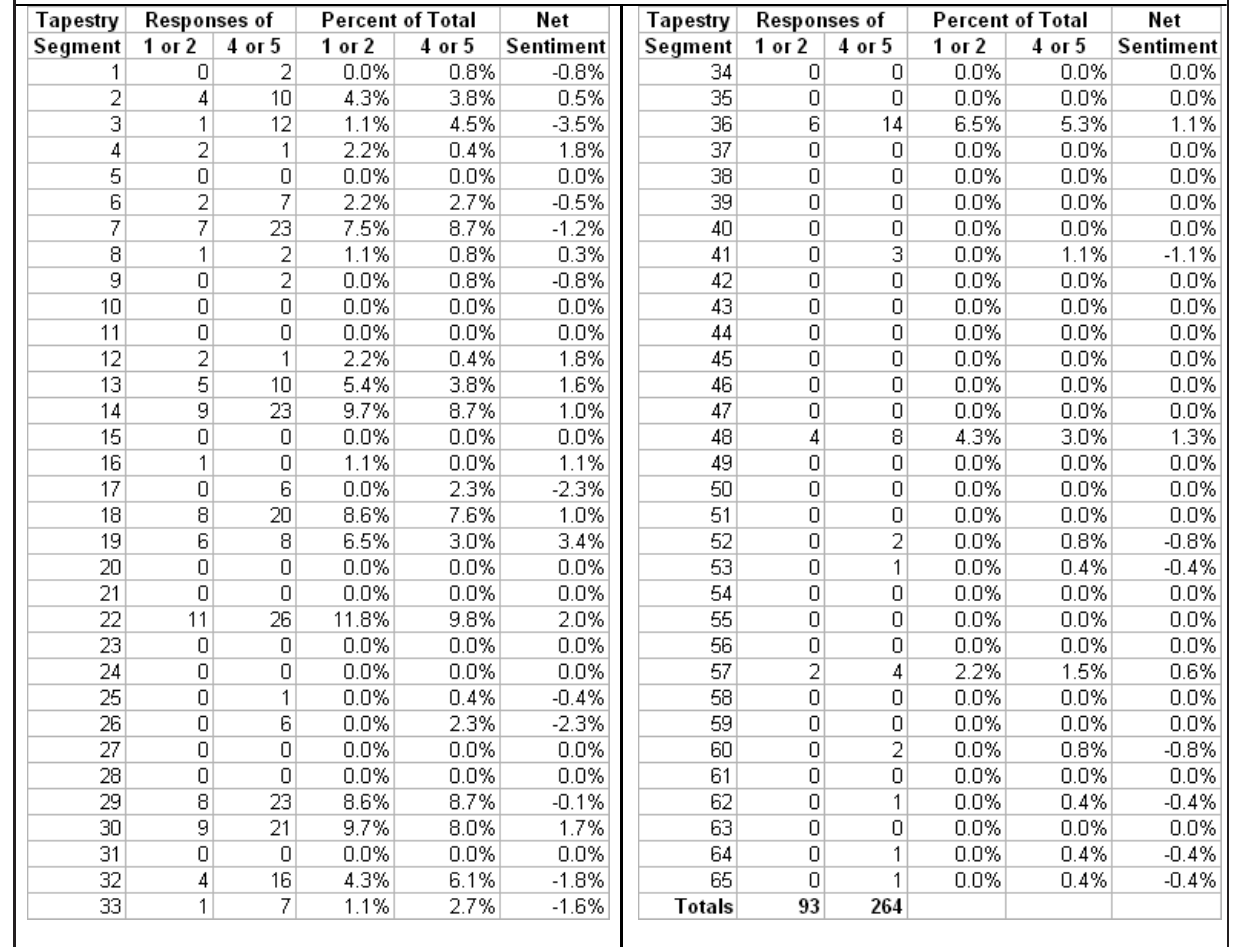
Table 4. Complete Tapestry Tally Table with Net Intent to